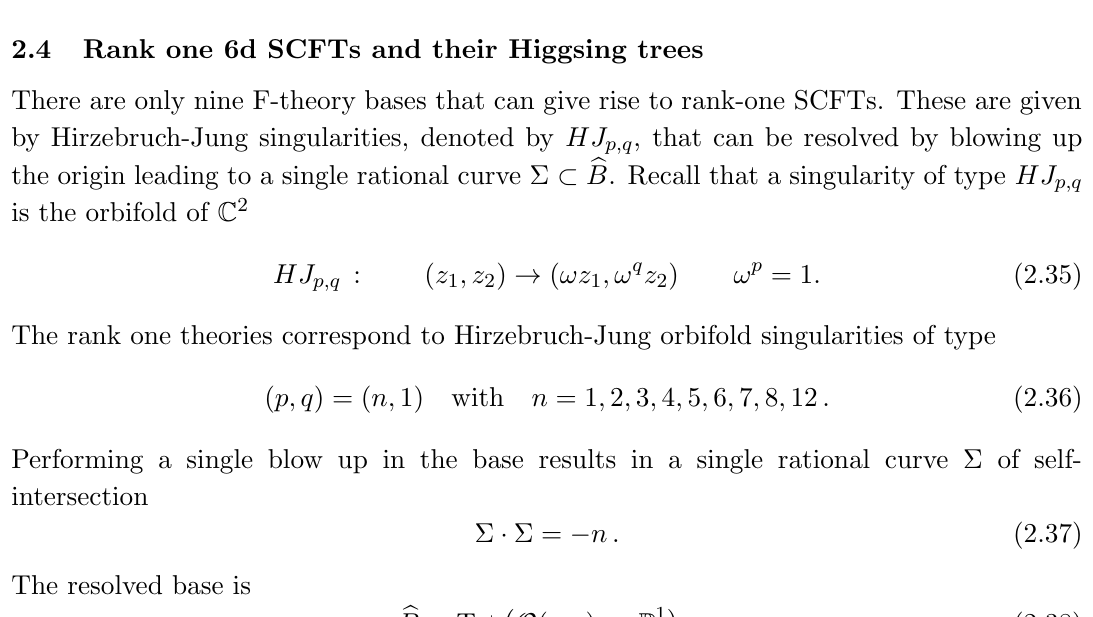
Table 5. HJ p;q singularities and corresponding minimal gauge groups for rank one 6d